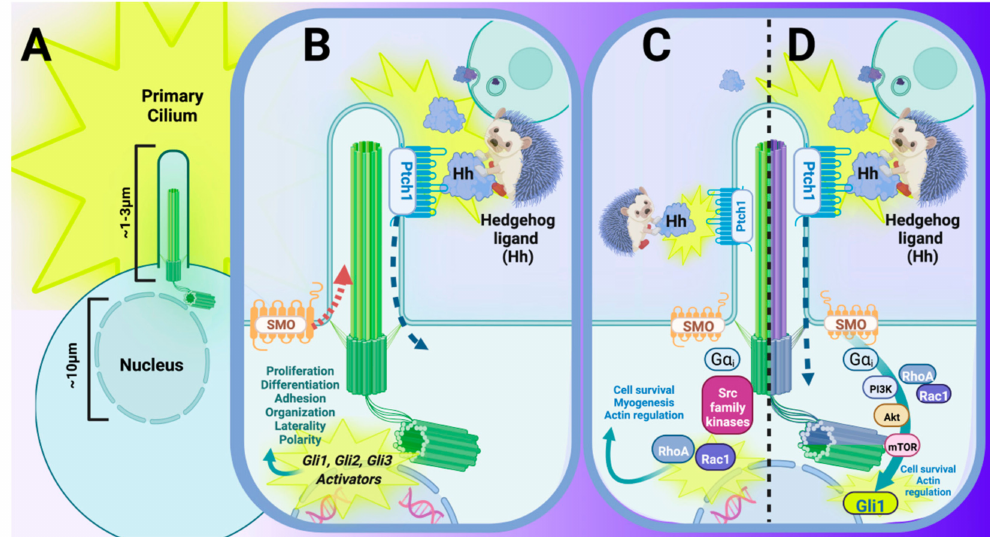
Figure 4. The primary cilium and its interaction with Hedgehog (Hh) signal transduction is criti- cal to many aspects of the developing mammal and maintenance of postnatal mammalian